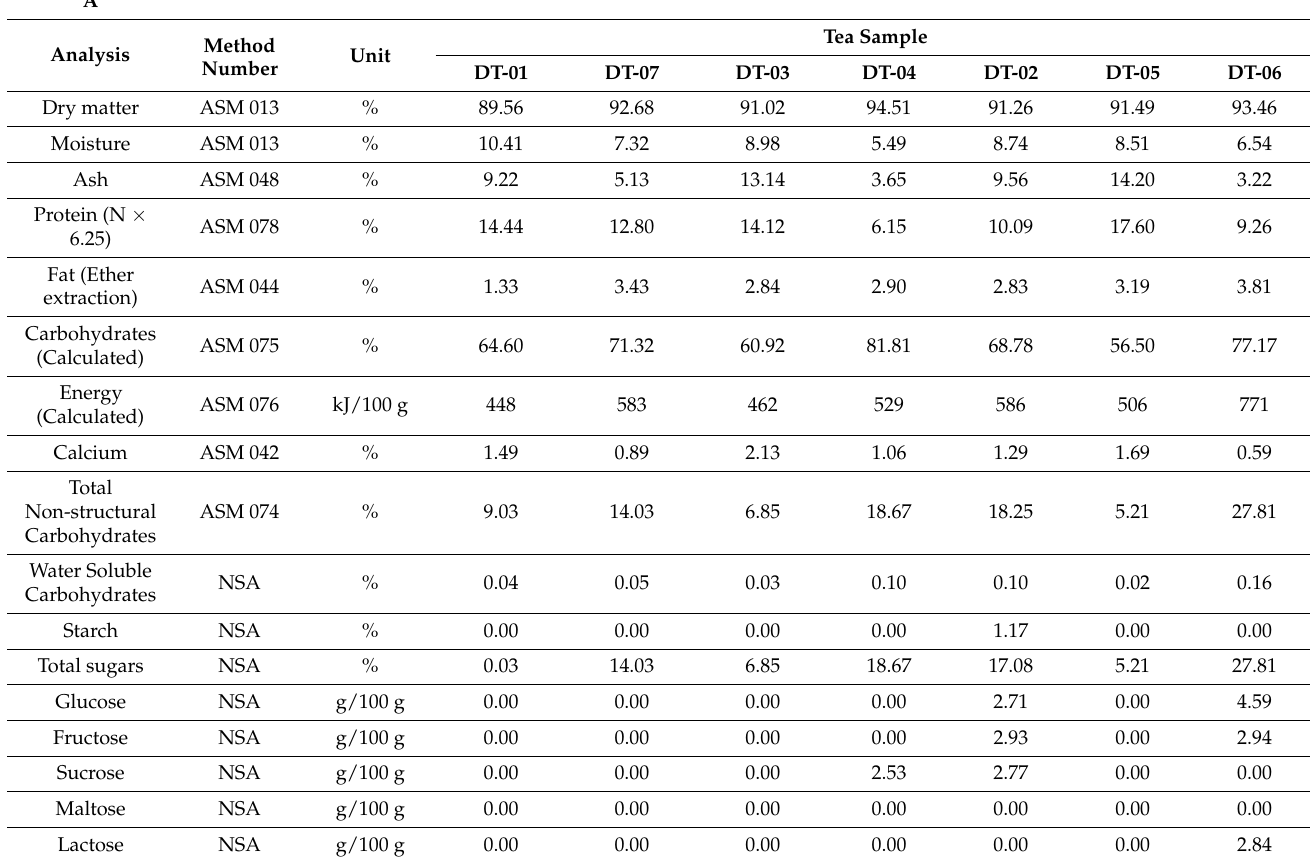
Table 3. Nutritional content of all the tea plants. ( A ) indigenous tea plants. ( B ) Nutritional and nutraceutical properties of all the tea